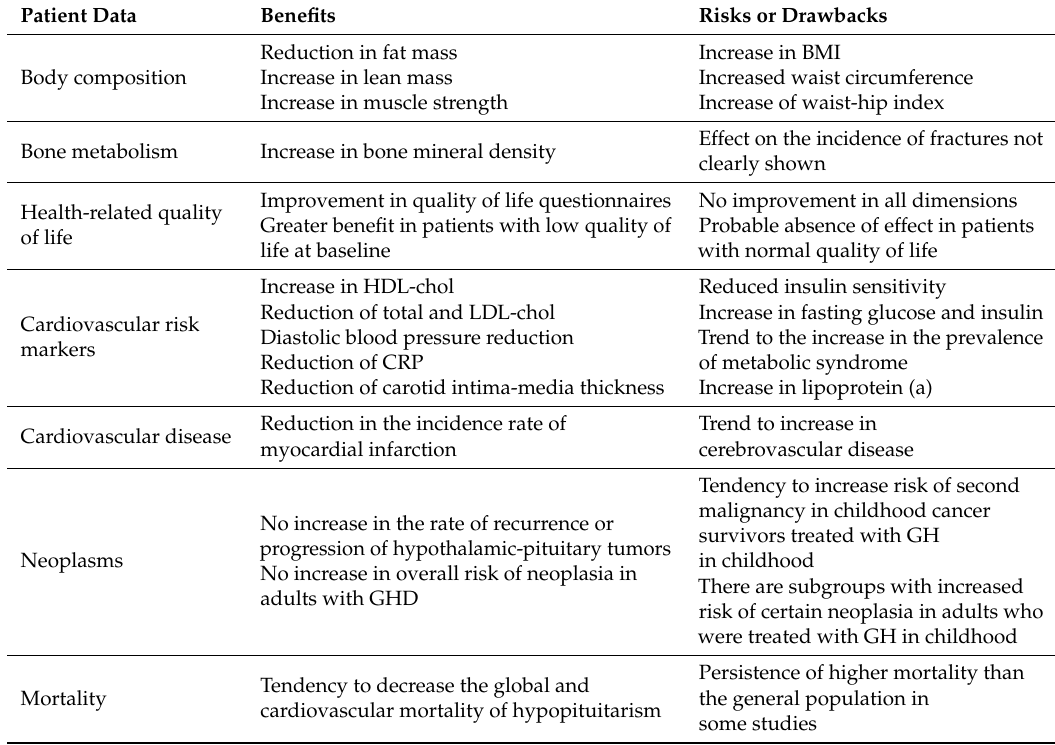
Table 1. Long-term benefits and risks of growth hormone replacement therapy in adult patients with growth hormone